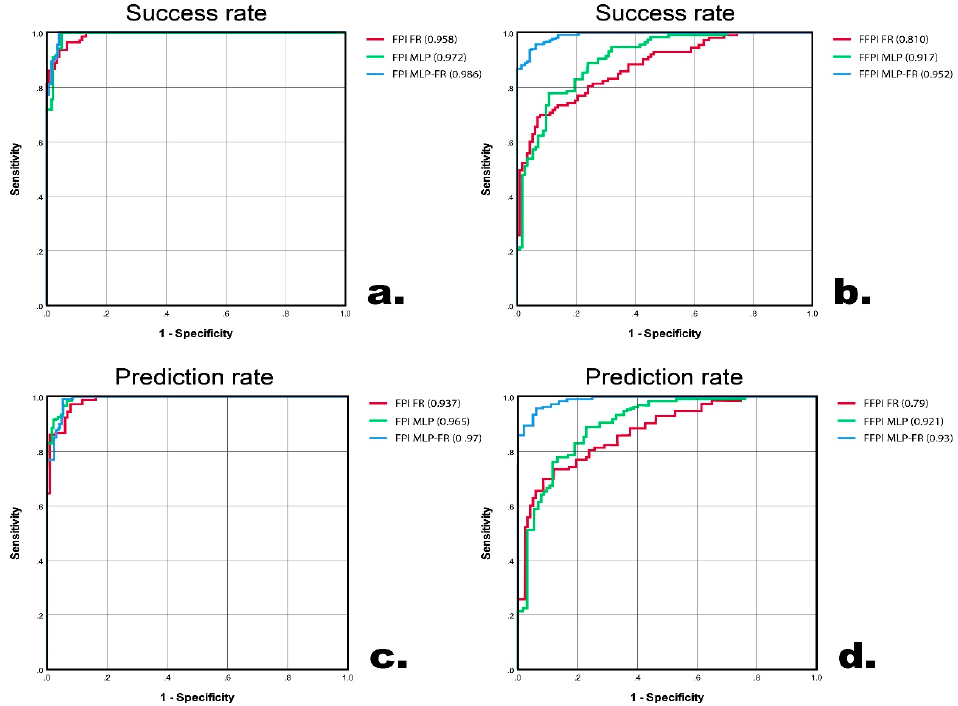
Figure 14. Reciever operating characteristic (ROC) curve and area under the curve (AUC) for the FPI ( a , c ) and FFPI ( b , d ) models.